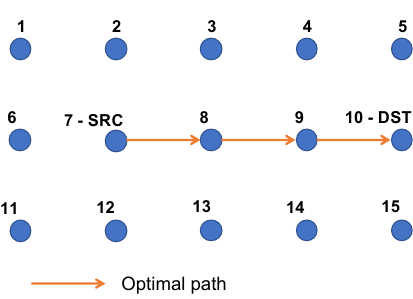
Figure 4. Network configuration for the adaptivity